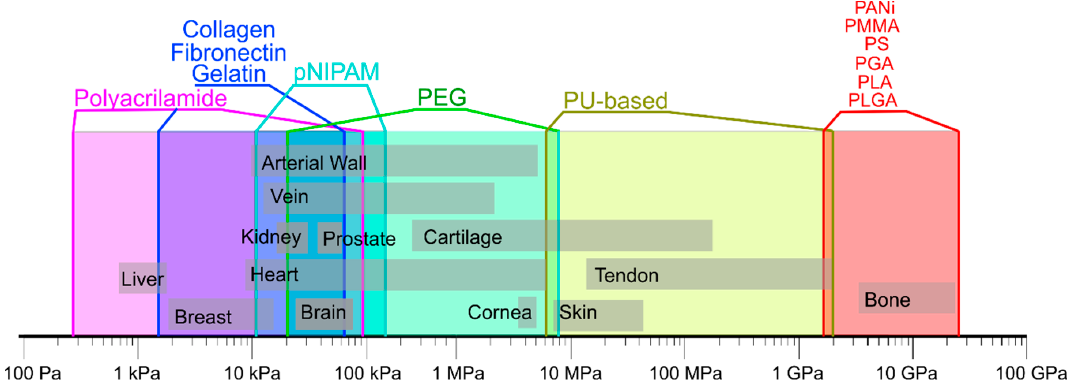
Figure 1. Mechanical properties of natural tissues and polymers. Data are composed based on data from the following publications [25,131,132].